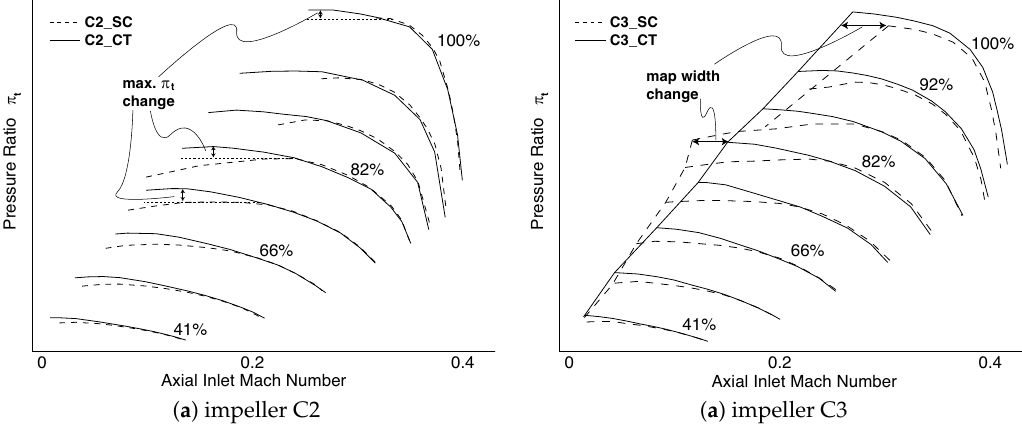
Figure 14. Experimental comparison of casing treatment (CT) results to smooth casing